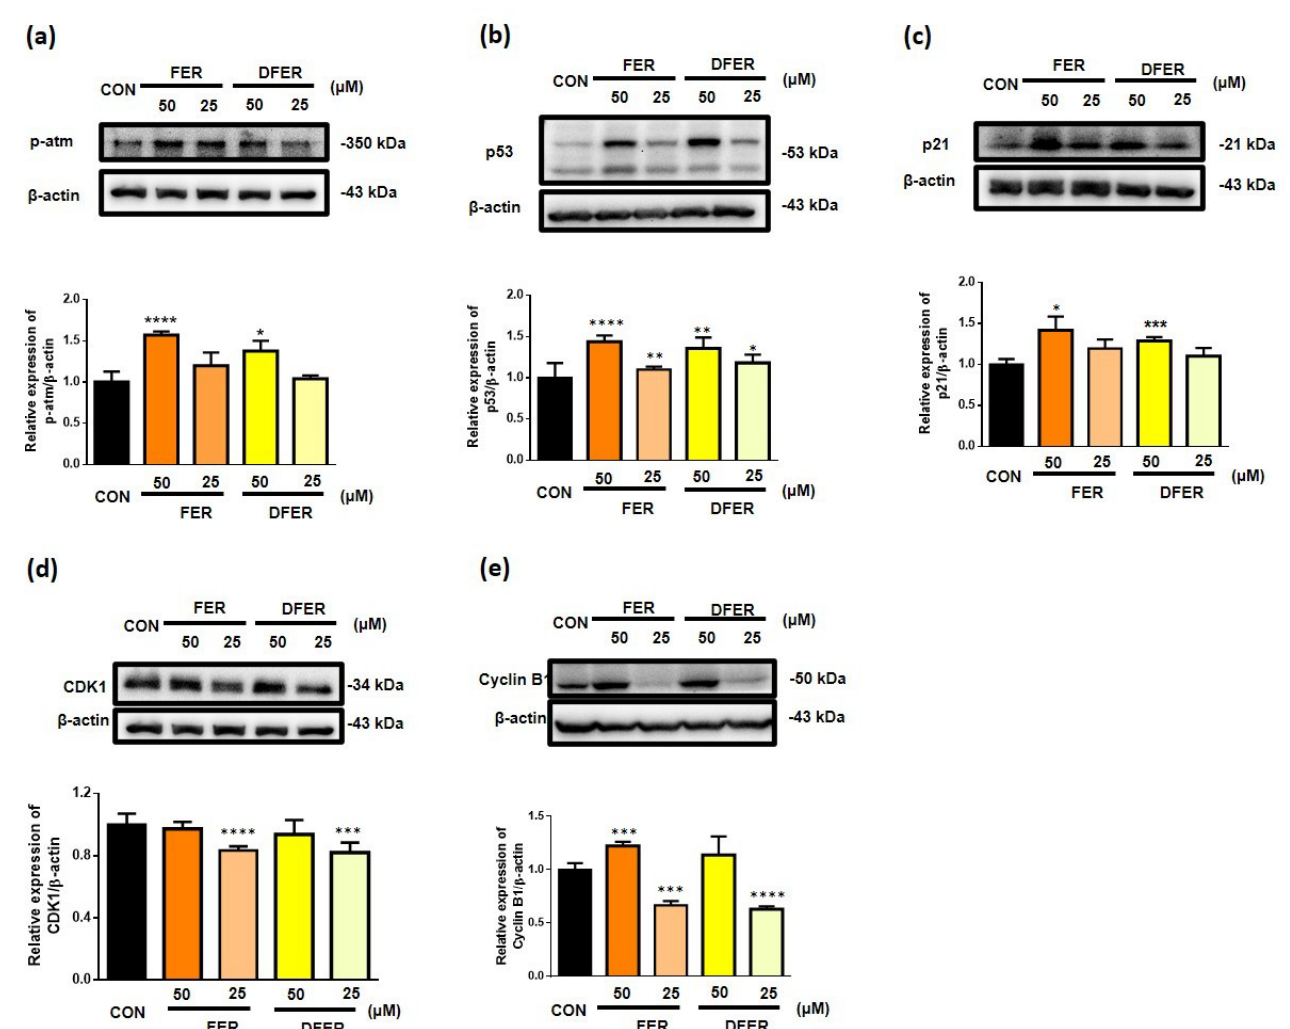
Figure 4. Both FER and DFER may lead to cell cycle arrest by activating the p53/p21 pathway and upregulating cyclin B1 expression. Representative protein expression and quantification of Western blotting of ( a ) p-atm, ( b ) p53, ( c ) p21, ( d ) CDK1 and ( e ) cyclin B1, by using β-actin as an internal control. Symbols (*), (**), (***) and (****) indicate significant differences ( p < 0.05), ( p < 0.01), ( p < 0.005) and ( p < 0.001), respectively, analyzed using Student’s t -test, as compared to the control group.